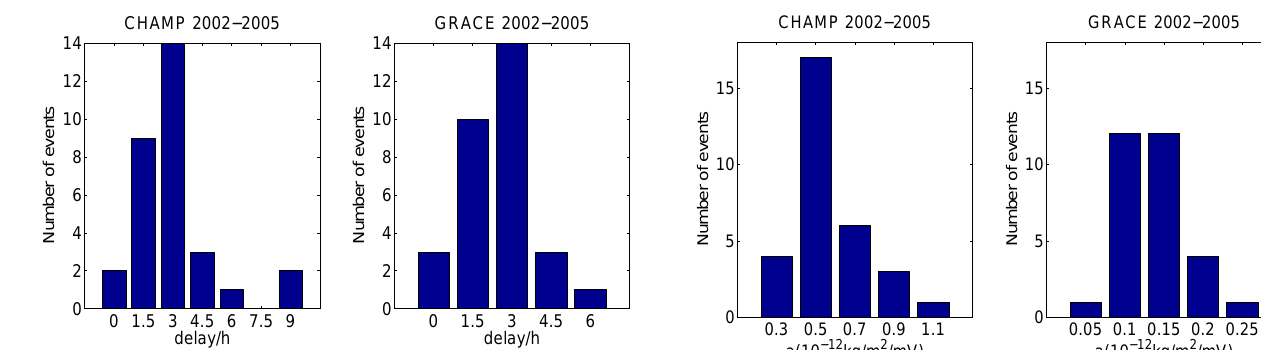
Fig. 3. The distribution of scaling factor a for CHAMP (left) and GRACE (right). The y-axis indicates the number of storm events per